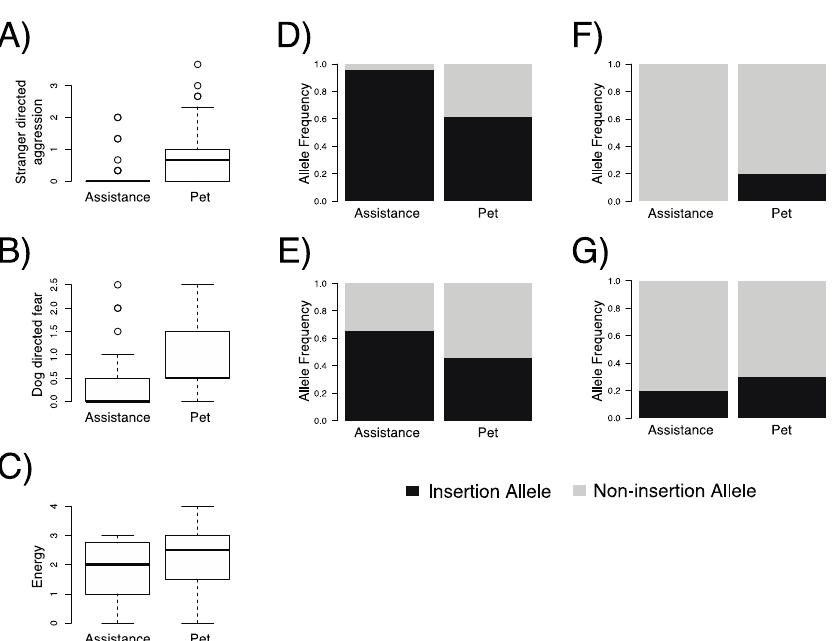
Figure 3. Mean and variation of C-BARQ © scores of behavioral types for assistance ( n = 49) and pet ( n = 69) dogs for ( A ) stranger-directed aggression; ( B ) dog-directed fear; and ( C ) energy. Bar graphs display the frequency of the inserted allele at each locus: ( D ) Cfa6.6; ( E ) Cfa6.7; ( F ) Cfa6.66; and ( G )